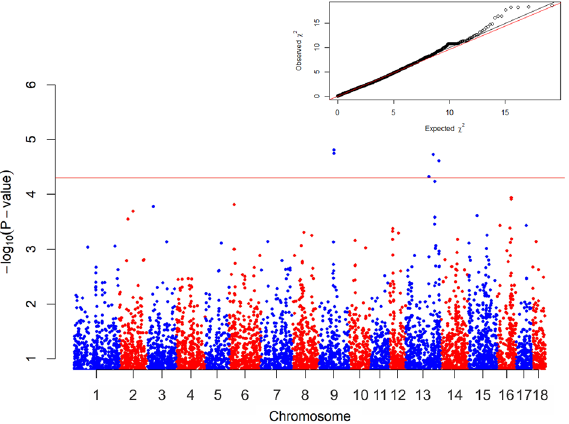
Figure 2. Manhattan plot of the test values obtained, for each marker for Brucella. The horizontal red line separated the seven most significant markers (P < 0.00005). ALGA0073505, WU 10.2 13 200912860,